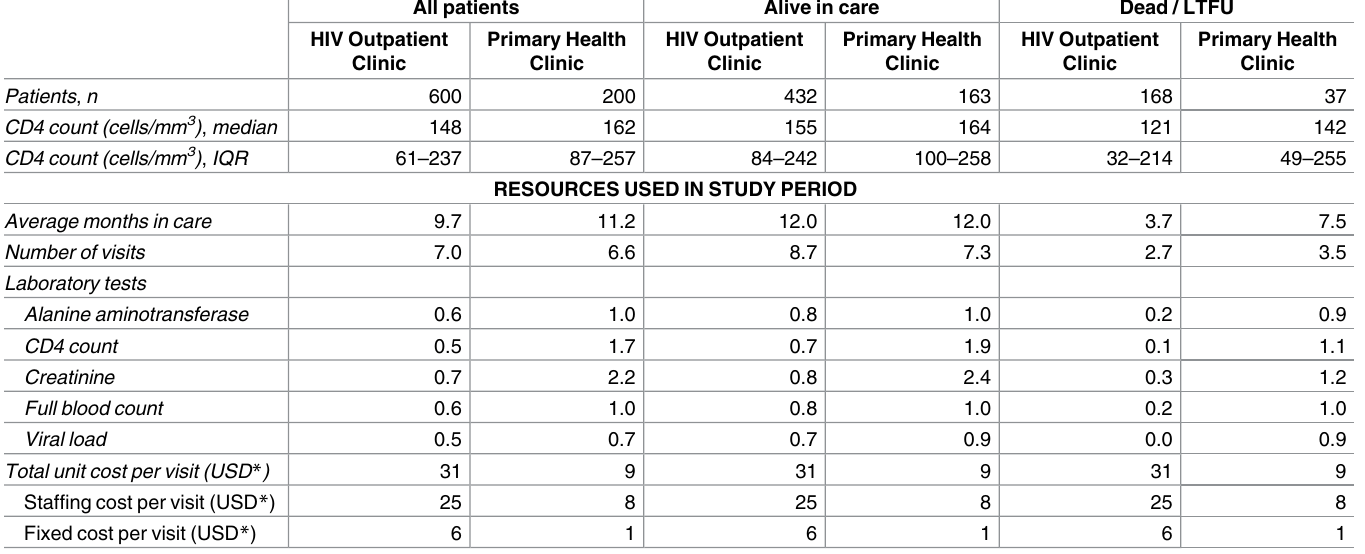
Table 4. Time in care (months) and resourceutilization for study period by outcome and facility. All